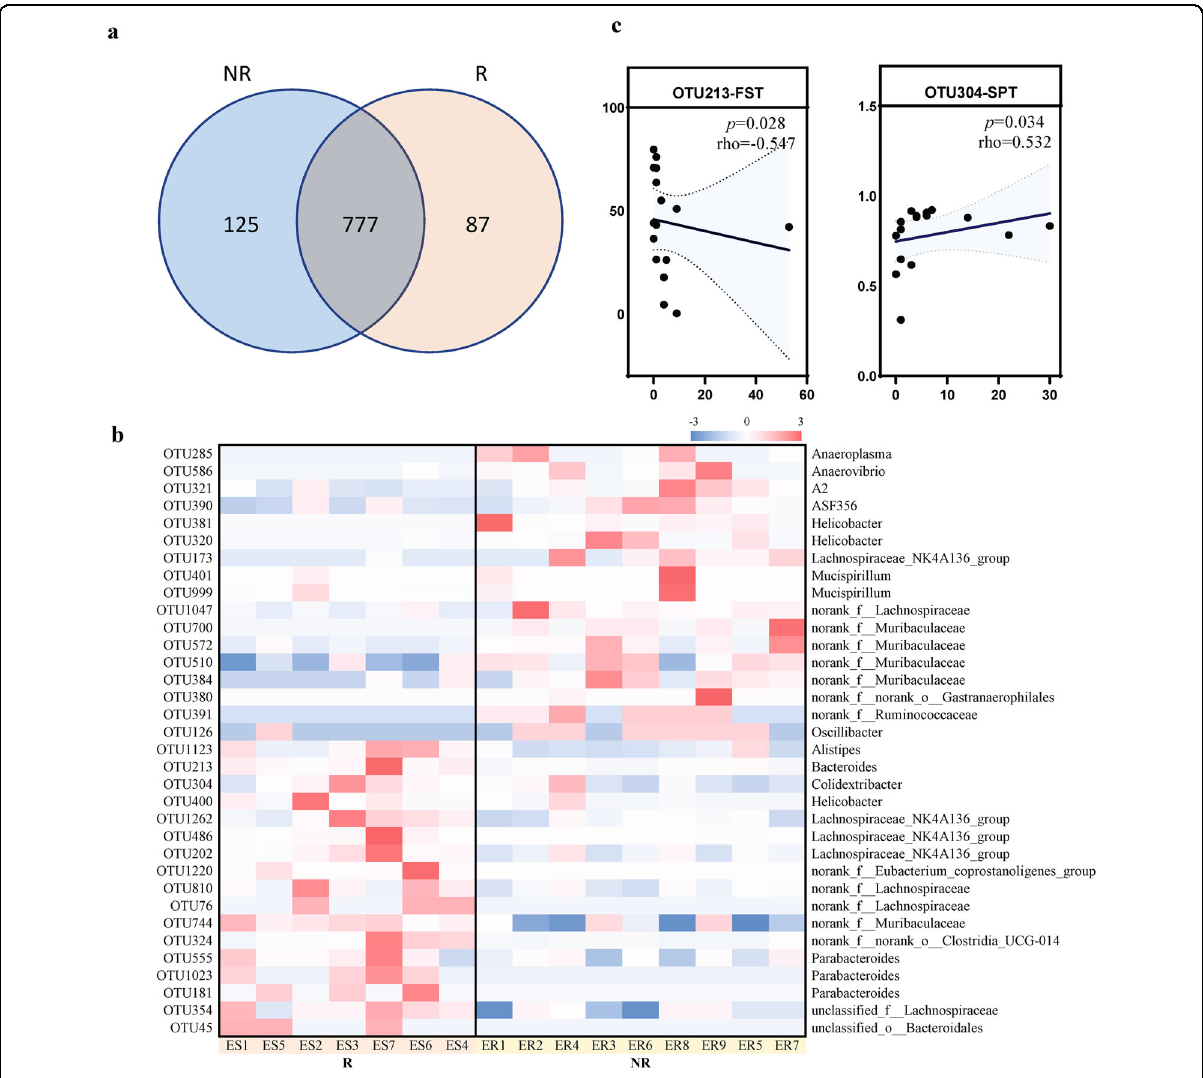
Fig. 4 Analysis of the OTUs enriched in R and NR groups in week 4. a Venn diagram showing the distribution of the OTUs between R and NR groups, 777 OTUs were shared between R and NR groups. b Heat map of discriminant OTUs determined by LEfSe analysis in fecal samples between R and NR group with the double criteria of both LDA > 2 and p < 0.05. Each column represents an individual sample, OTUs are classi fi ed in genus format on the right side. c Scatter diagram of the relative abundances of the behavior-related OTUs. The correlation was tested by Spearman correlation analysis. FST, forced swim test. SPT, sucrose preference